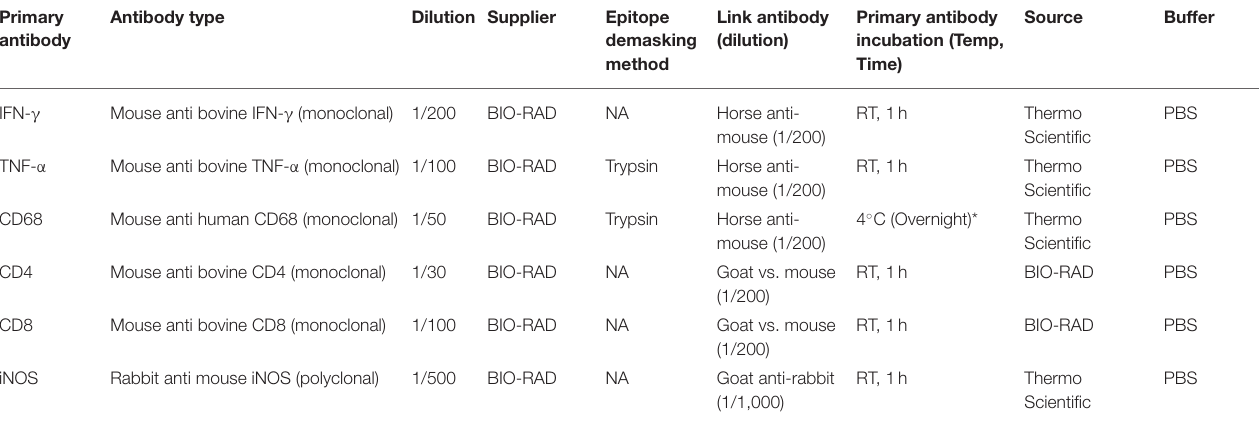
TABLE 1 | Immune markers used for immunohistochemistry. Primary Antibody type antibody